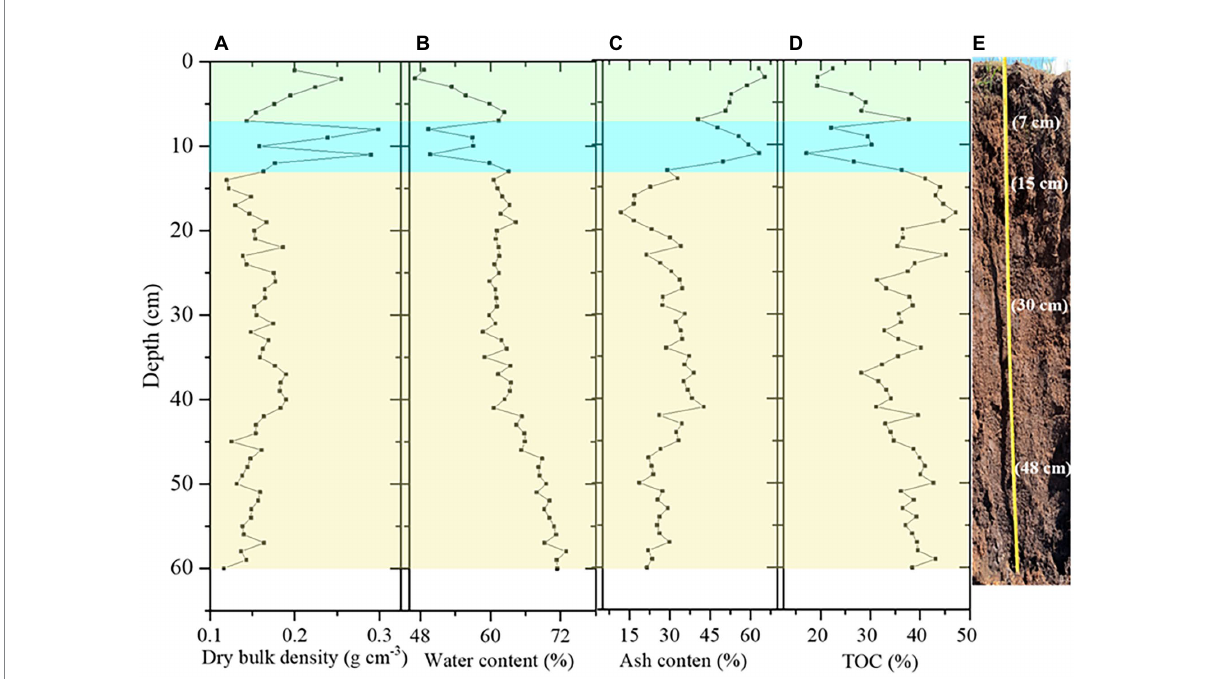
FIGURE 2 The depth profiles of dry bulk density (A) , water content (B) , ash content (C) , TOC (D) and the core section of the peat column (E) in the JDY peat core in Altay Mountains, NW